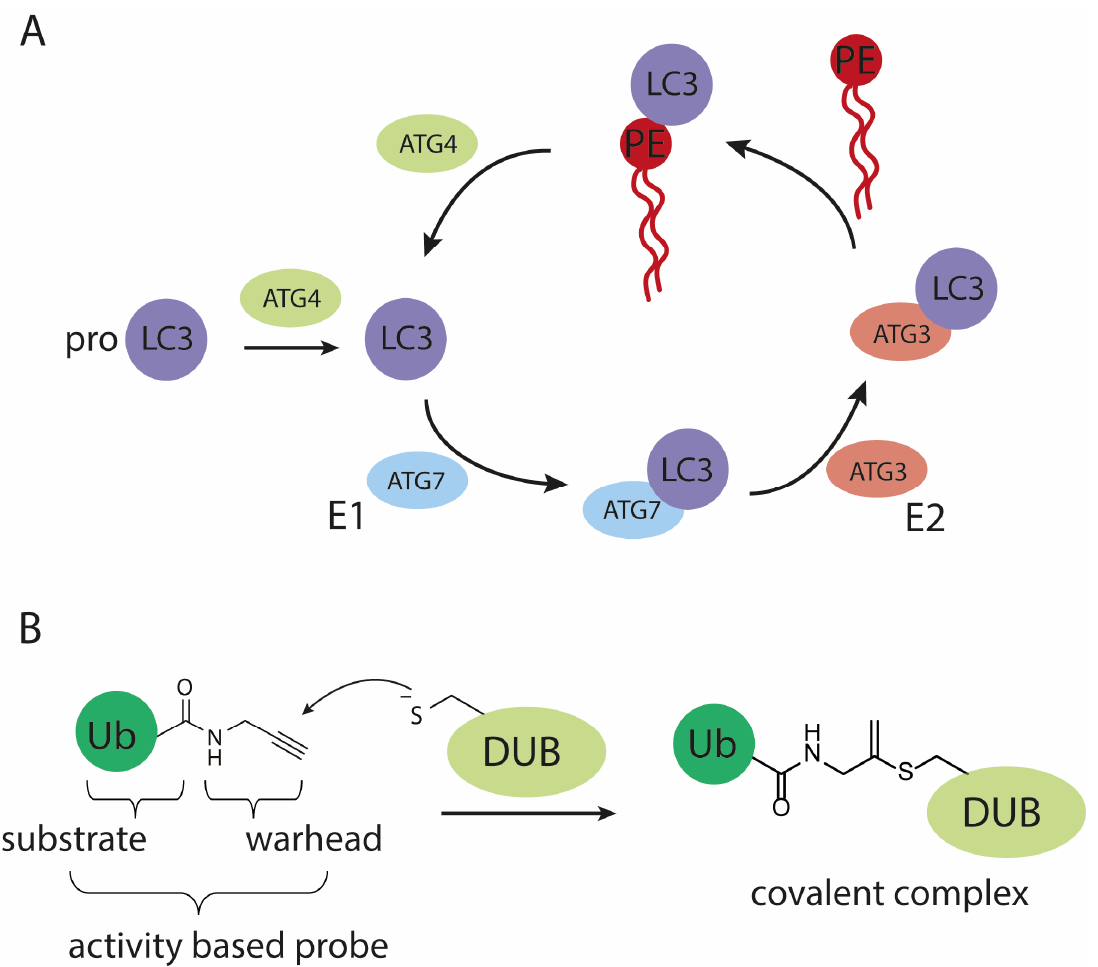
Figure 1. Schematic representation of ( A ) the (de)conjugation machinery involved in maturing and processing LC3, ( B ) the mode of action of an active cysteine deubiquitylating protease (DUB) on a propargylamide activity-based probe.